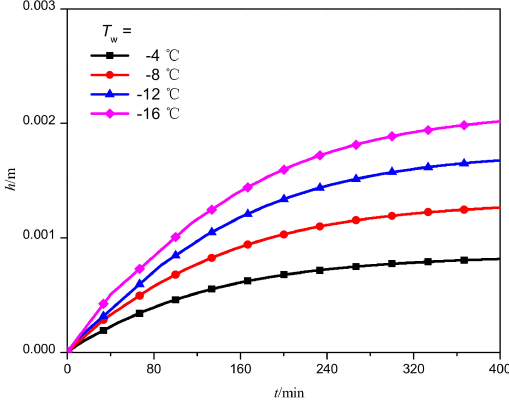
Figure 5. Variation of frost thickness over